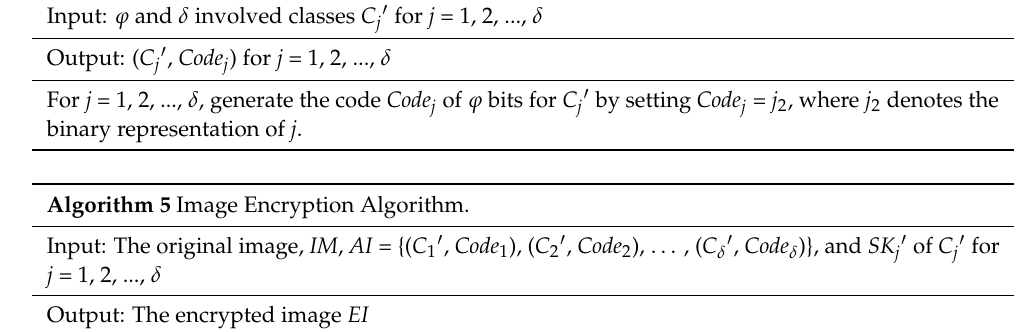
Algorithm 4 Coding Algorithm.